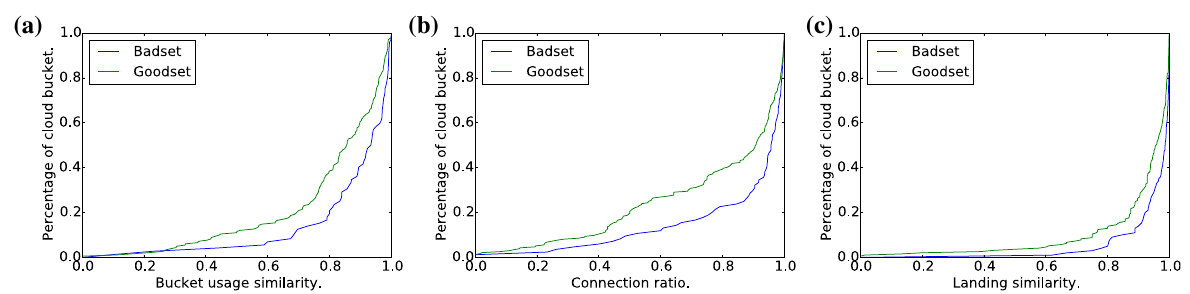
Fig. 4 Bars show smaller topological diversity. a Cumulative distribution of bucket usage similarity per cloud bucket. b Cumulative distribution of connected ratio per cloud bucket. c Cumulative distribution of landing similarity per cloud